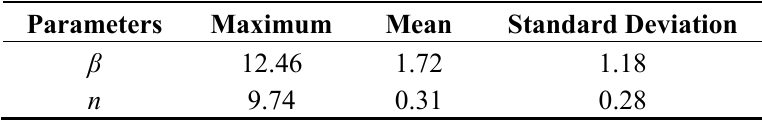
Table 1. Statistical values of the parameters β and n